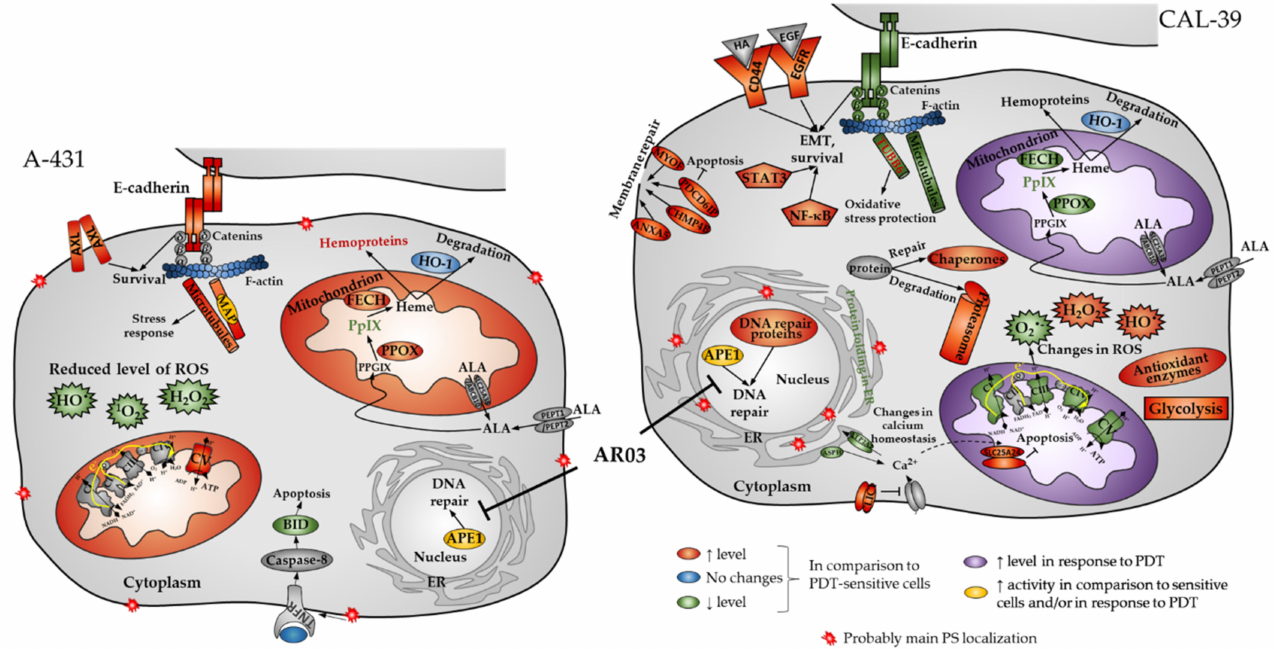
Figure 11. Mechanisms leading to resistance to photodynamic therapy (PDT) in vulvar cancer cells. Resistance to PDT vulvar cancer cells changed the amount of heme metabolism enzymes (PPOX, FECH) which led to decreased protoporphyrin IX (PpIX) levels in this cells [6]. Resistant cells also showed changes in the number of mitochondria and cellular metabolism, as well as ROS and antioxidant capacity. Changes in the cytoskeleton (E-cadherin, β -tubulin) that led to epithelial- mesenchymal transition (EMT) or increased adhesion can also contribute to resistance as a result of activation of survival pathways. Moreover, resistant cells increased the ability to repair/remove PDT-induced damage and could avoid cell death. Inhibition of APE1 DNA repair function effectively sensitizes cells to PDT [6]. The figure was prepared based on the results obtained by our group and described in this and previous [6] article and their Supplementary